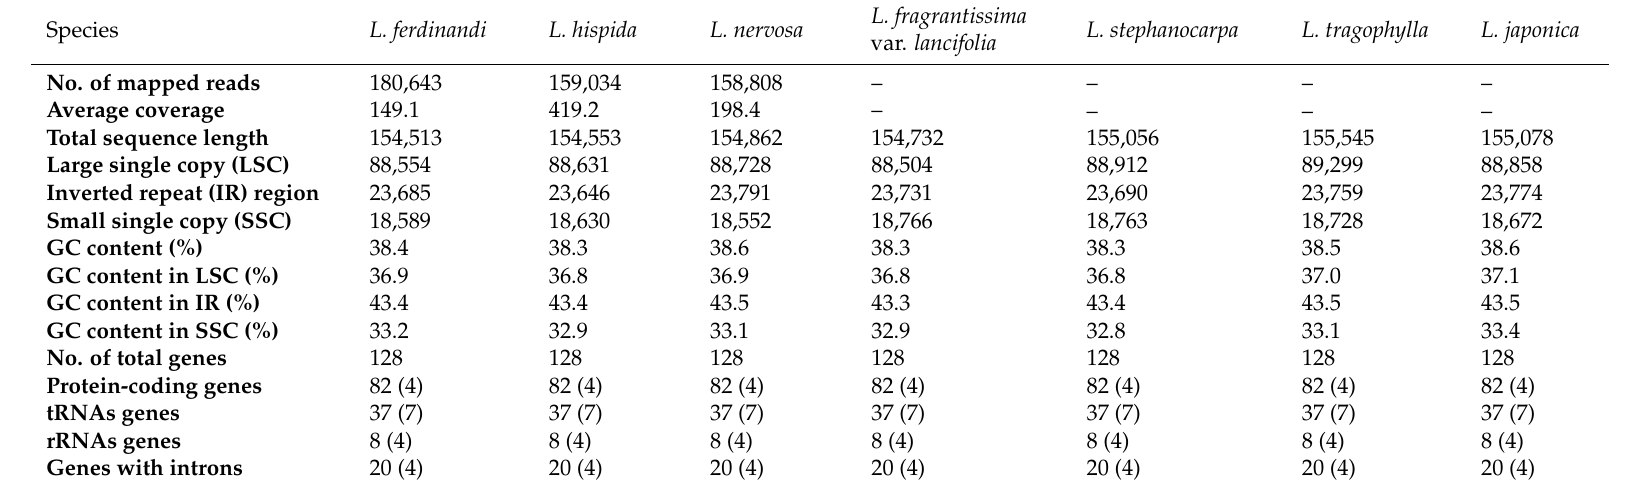
Table 1. The features of chloroplast genomes of seven Lonicera